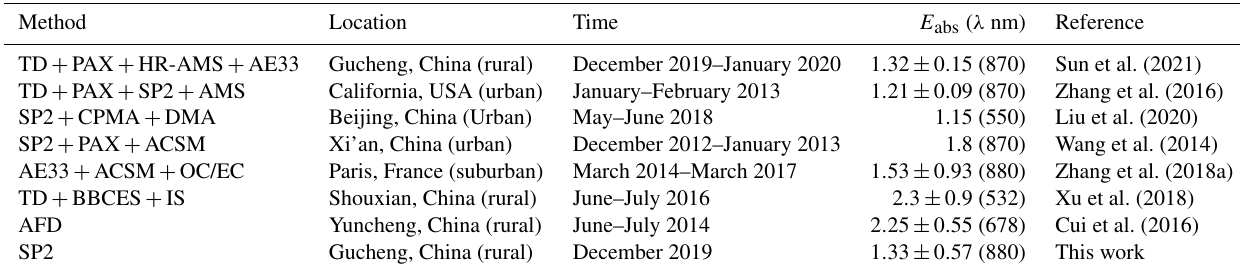
Table 2. Comparisons of E abs in various field studies.